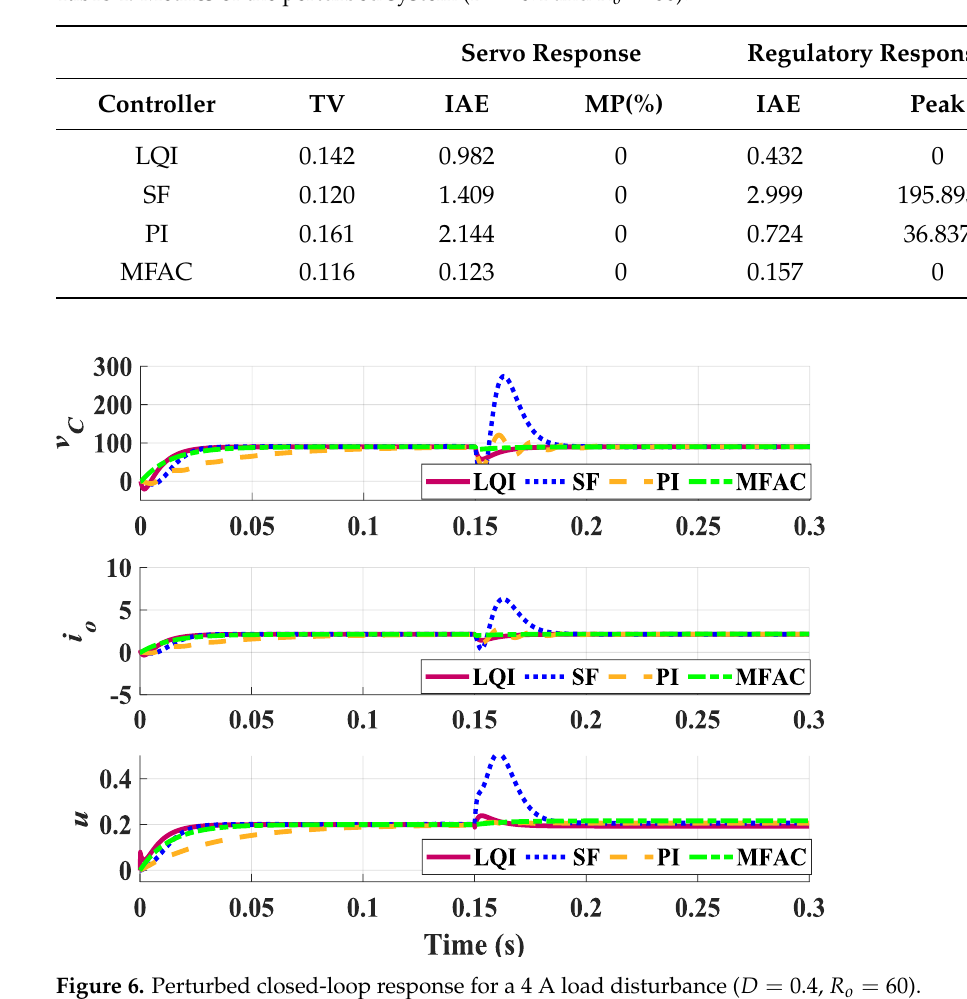
Figure 5. Perturbed closed-loop response for a 4 A load disturbance ( D = 0.45, R o = 60). Table 4. Metrics of the perturbed system ( D = 0.4 and R o = 60).